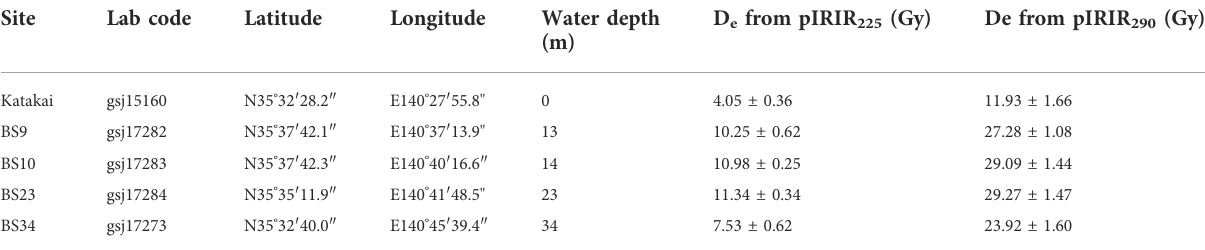
TABLE 2 Details of the modern samples collected in the Kujukuri beach and offshore areas. Equivalent doses ( D e ) determined are considered as residual